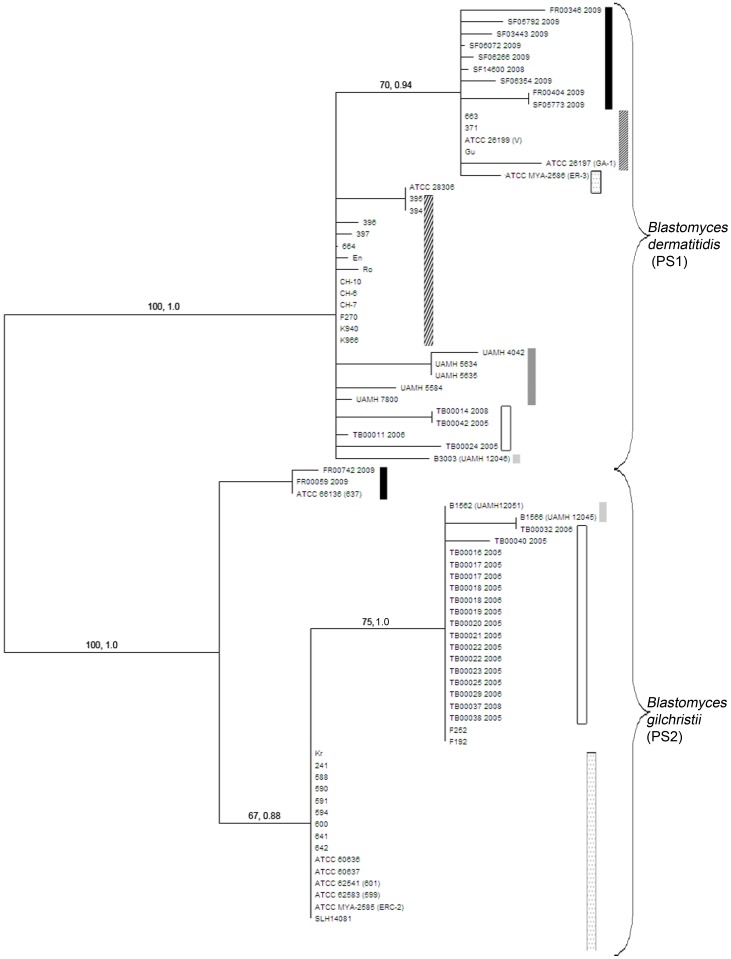
Maximum-parsimony tree constructed from the concatenated sequences of seven nuclear genes (chs2-drk1-fads-pyrF-tub1-arf6-its2).
A majority consensus mid-point rooted maximum parsimony (MP) tree was constructed based on the concatenated sequence of seven MLST gene loci. The MP tree is displayed without logarithmic scaling so that genetic distance and geographic region of isolation could be viewed. Values along branches represent maximum parsimony bootstrap values (MPB) and Bayesian posterior probability (BPP) values respectively. Values for branches partitioning less than three isolates or those with MPB ≤70 and BPP≤0.95 are not shown. The tree is displayed with pattern coding for geographic regions as described in Figure 1. The MP tree displays a partition in the current species B. dermatitidis into two phylogenetic species: B. dermatitidis (PS1, clade 1) and B. gilchristii (PS2, clade 2).